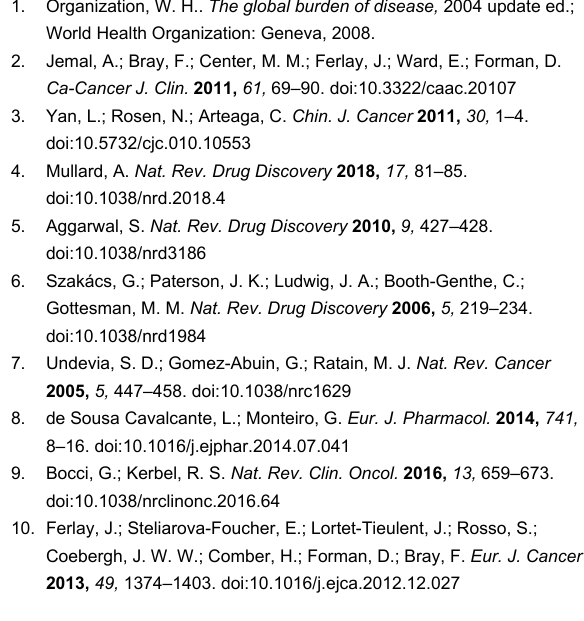
the relatively low cost for the construction of PDCs have rendered them appealing candidates. In the present